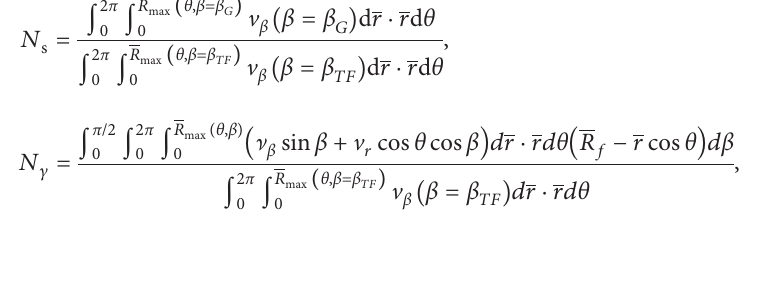
Figure 7: Layout of the derived continuous velocity field for shallow tunnel blow-out ( C/D � 0.5, c D / s downward movement; (b) tunneling in upward